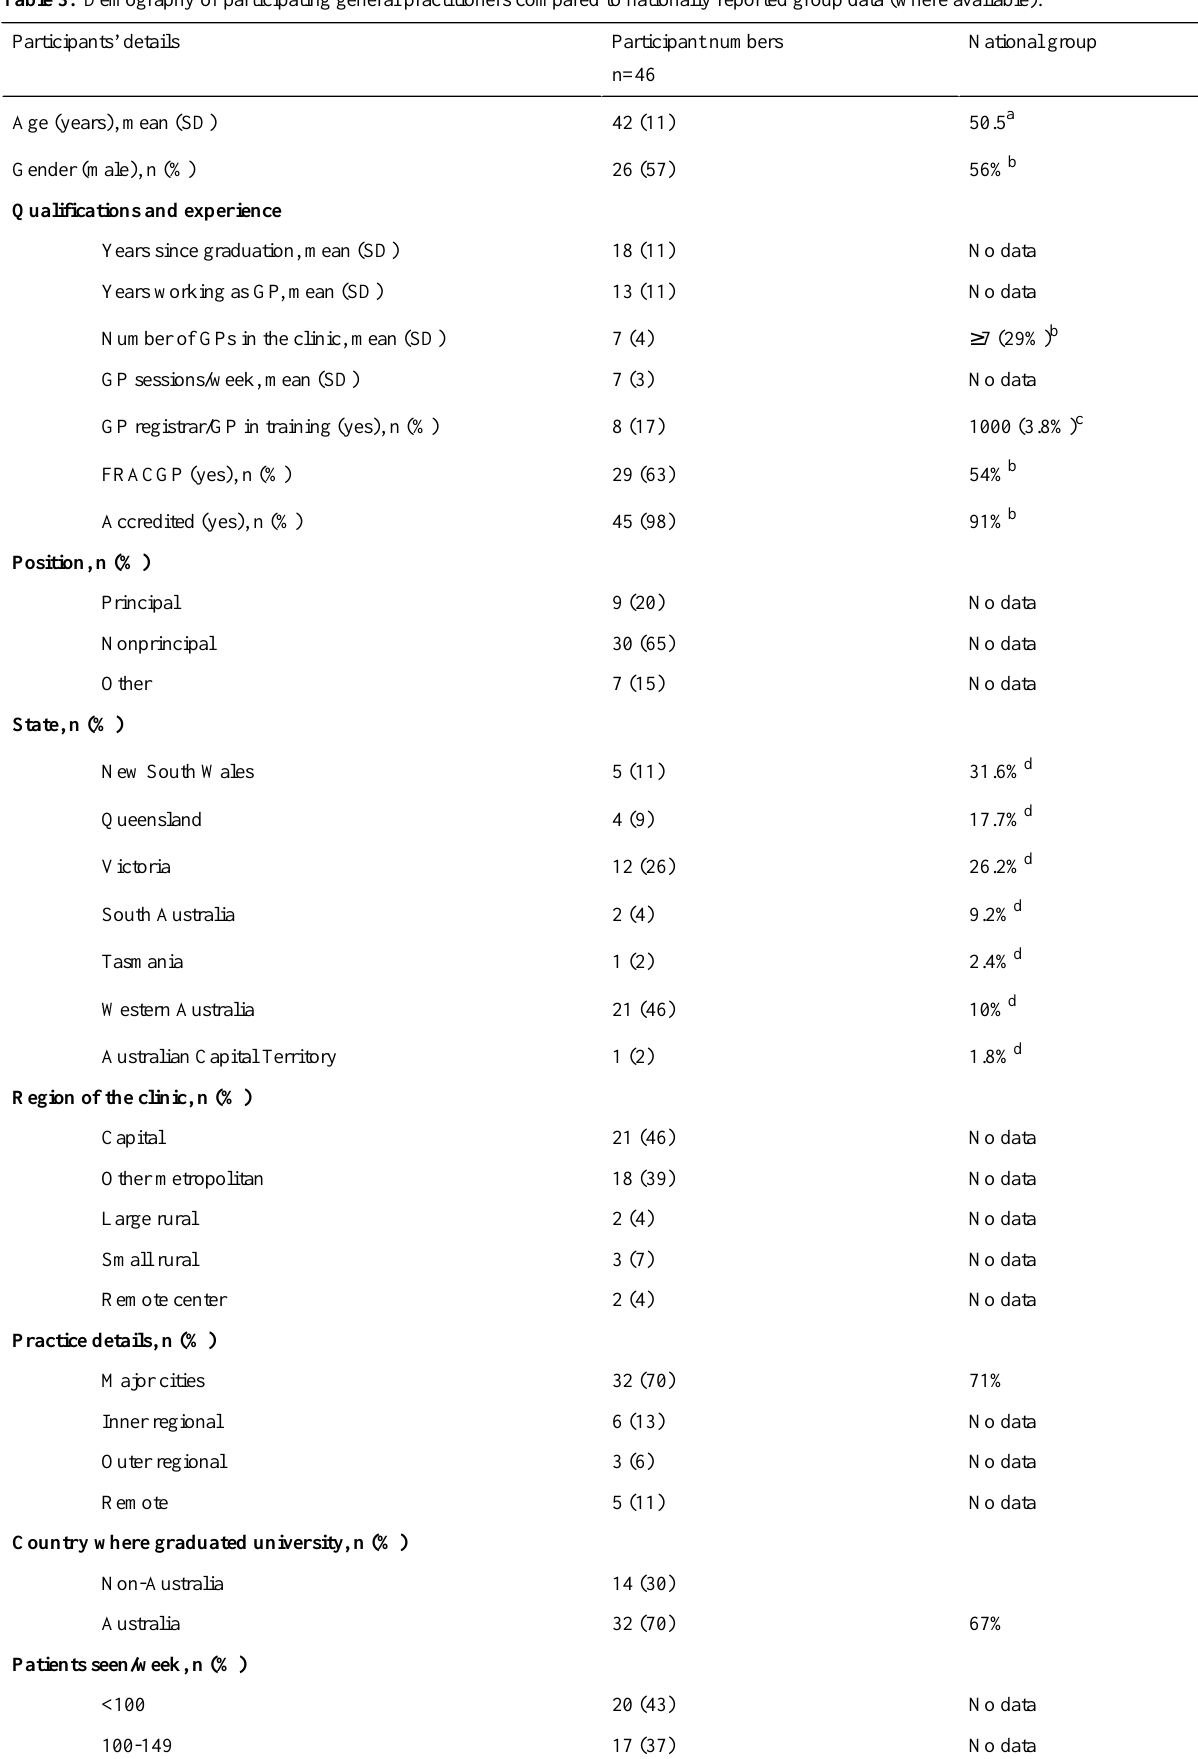
Table 3. Demography of participating general practitioners compared to nationally reported group data (where